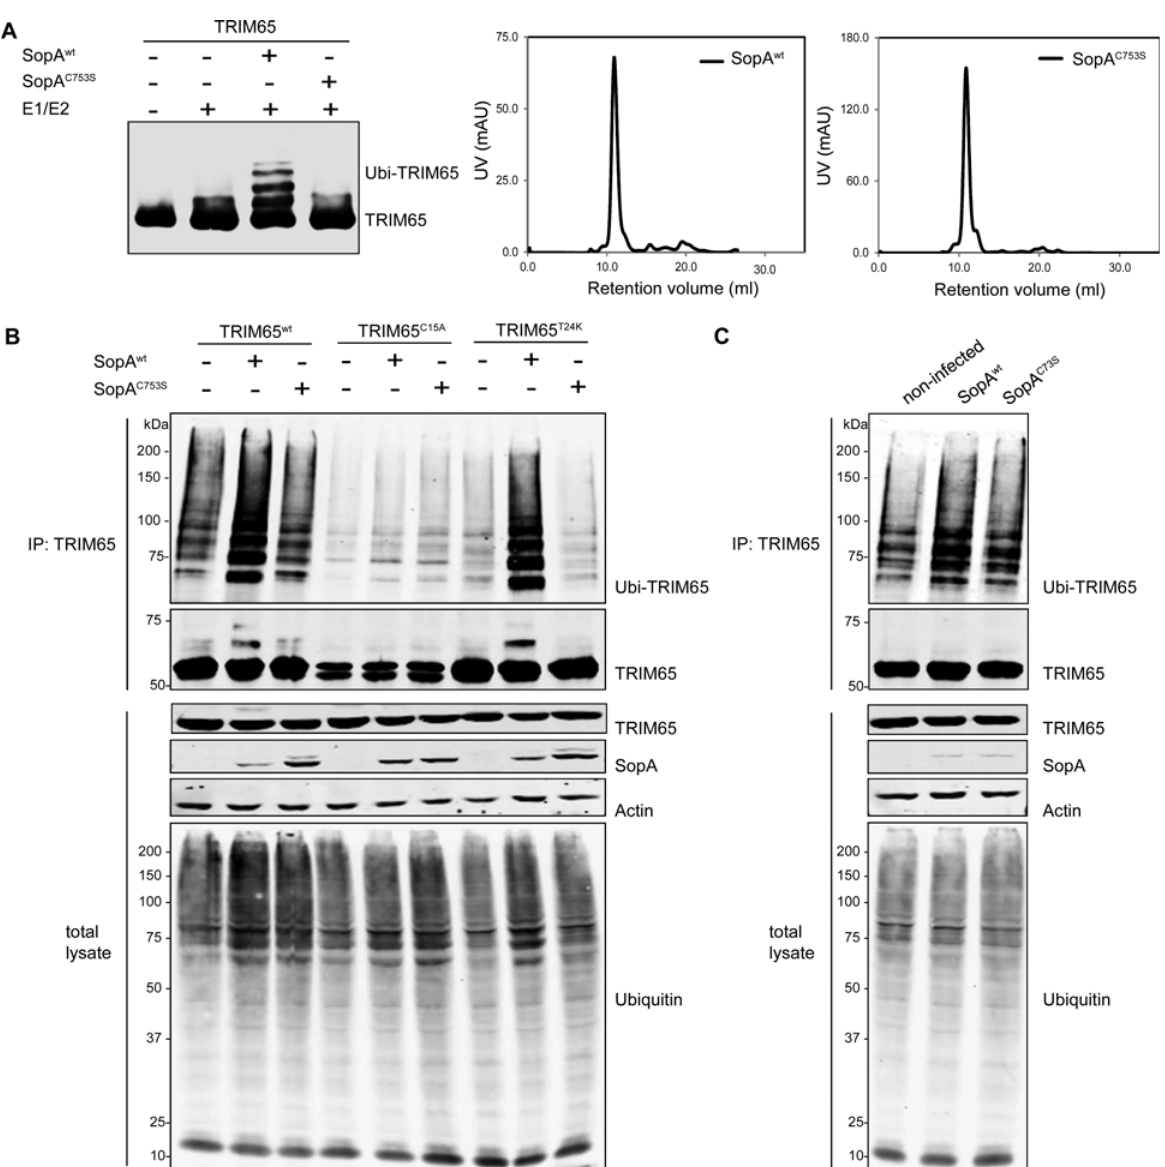
Fig 3. SopA enhances TRIM65 ubiquitination. ( A ) Purified FLAG-epitope-tagged TRIM65 was incubated with SopA or its catalytic mutant SopA C753S in the presence of ubiquitin, ATP, E1 (UBE1) and E2 (UbcH5b) and TRIM65 ubiquitination was detected by its mobility shift in Western blot analysis with anti-FLAG antibody. The chromatographic profiles of the SopA preparations used in the assays are shown. ( B ) HEK293T cells were co-transfected with plasmids encoding HA-epitope-tagged ubiquitin, and either FLAG-epitope-tagged TRIM65, or the mutants TRIM65 C15A (catalytically deficient) and TRIM65 T24K (autoubiquitination deficient) along with plasmids encoding either SopA or its catalytic mutant SopA C753S . Cell lysates were evaluated for the levels of protein expression and TRIM65 ubiquitination by immunoprecipitation with anti-FLAG and Western immunoblot analysis with anti-FLAG, anti-HA, and anti-M45 antibodies, respectively. This experiment was repeated 2 independent times with similar results. ( C ) HEK293T cells were co-transfected with plasmids encoding HA-epitope-tagged ubiquitin and FLAG-epitope tagged TRIM65 and 18 hours after transfection, cells were infected with an S . Typhimurium strain expressing either wild type SopA or its catalytic mutant SopA C753S . Five hours after infection, cell lysates were evaluated for the levels of protein expression and TRIM65 ubiquitination by immunoprecipitation and Western immunoblot analysis with anti-FLAG, anti-HA, and anti-M45 antibodies, respectively. This experiment was repeated 3 independent times with similar